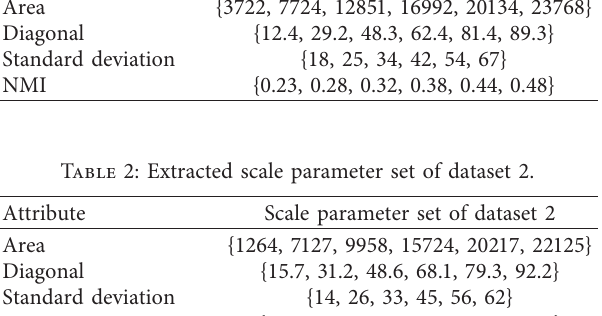
Figure 2: Experimental datasets: (a) Dataset 1 and patches I1 (red box) and I2 (blue box); (b) Dataset 2 and patches I3 (red box) and I4 (blue box); (c) Dataset 3 and patches I5 (red box) and I6 (blue box). Table 1: Extracted scale parameter set of dataset 1. Attribute Scale parameter set of dataset 1